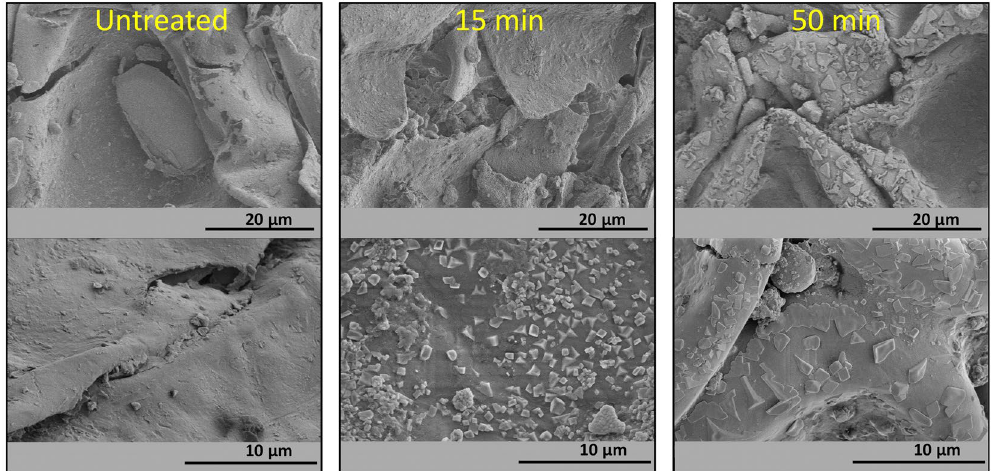
Figure 5. High magnification SEM images (top to bottom) of Quinoa seeds as received (left) and subjected to 15 (middle) and 50 min (right) DBD